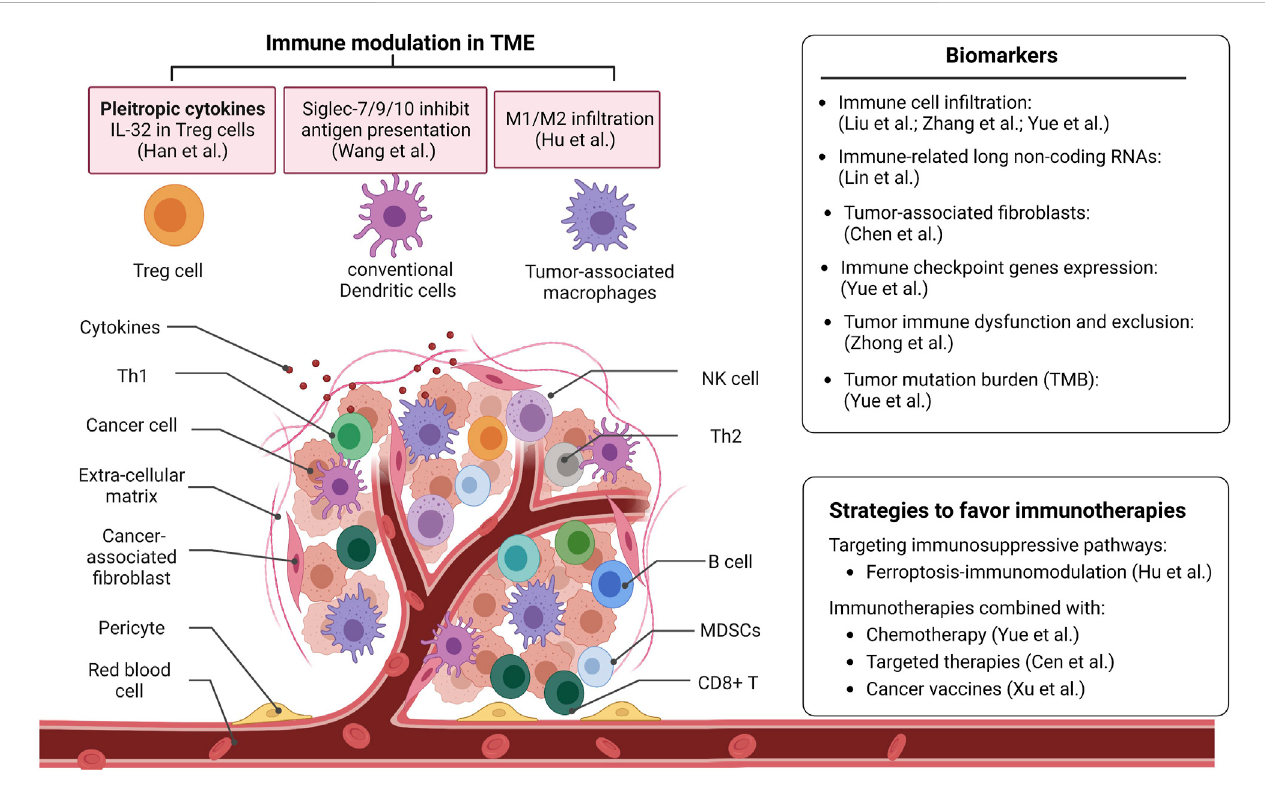
FIGURE 1 The representativestudies from theResearch Topic advance theunderstanding ofthetumor microenvironment.This ResearchTopic also provides new biomarkers for predicting immune checkpoint blockade therapy and approaches to favor immunotherapies. NK cell: Natural Killer cell; Th1: Type 1T helper; Th2: Type 2 T helper; MDSCs: Myeloid-derived suppressor cells.